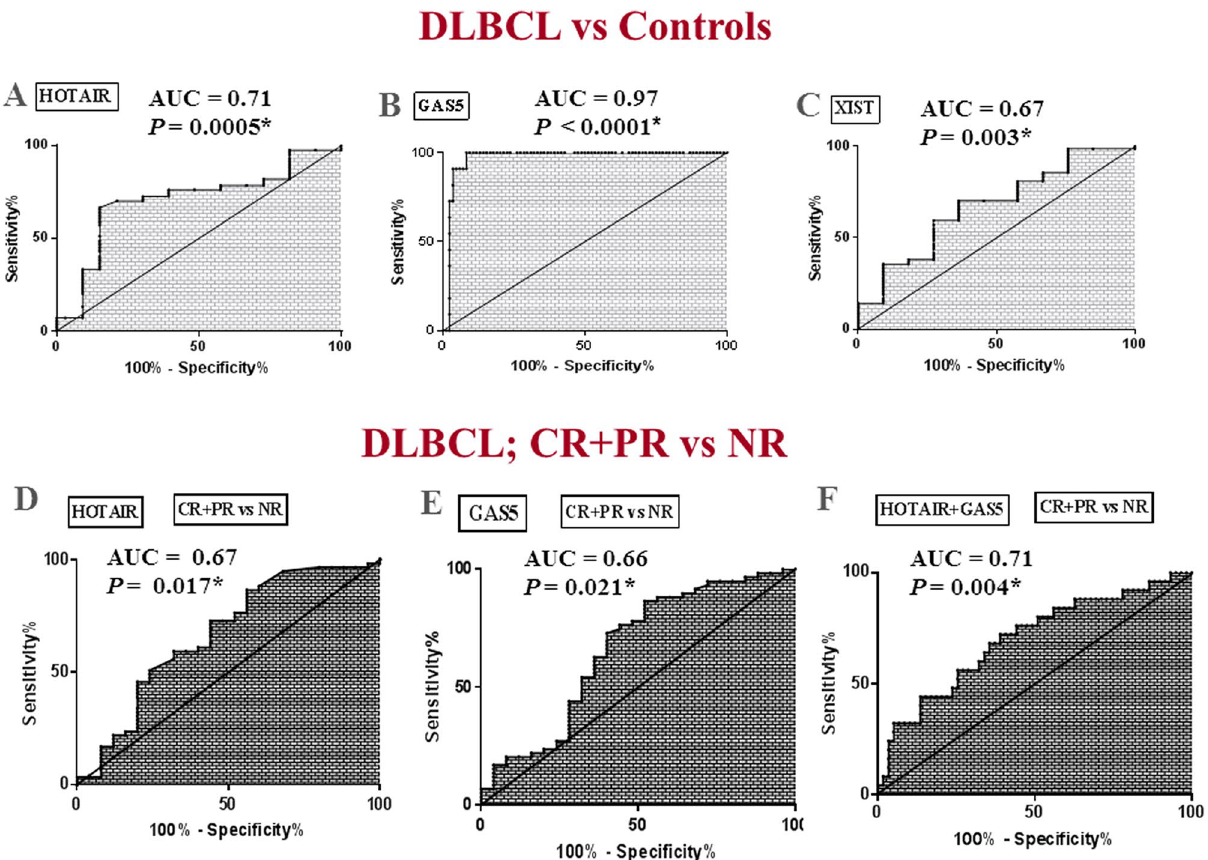
Figure 4. Plasma lncRNAs as biomarkers of DLBCL diagnosis and therapy outcome. ( A–C ) ROC curve analysis of plasma ( A ) HOTAIR, ( B ) GAS5 and ( C ) XIST as diagnostic biomarkers differentiating DLBCL patients (n = 84) from healthy controls (n = 33). ( D–F ) ROC analysis of plasma ( D ) HOTAIR and ( E ) GAS5, ( F ) HOTAIR + GAS5 to differentiate overall responders (n = 59) from NR (n = 25) among DLBCL